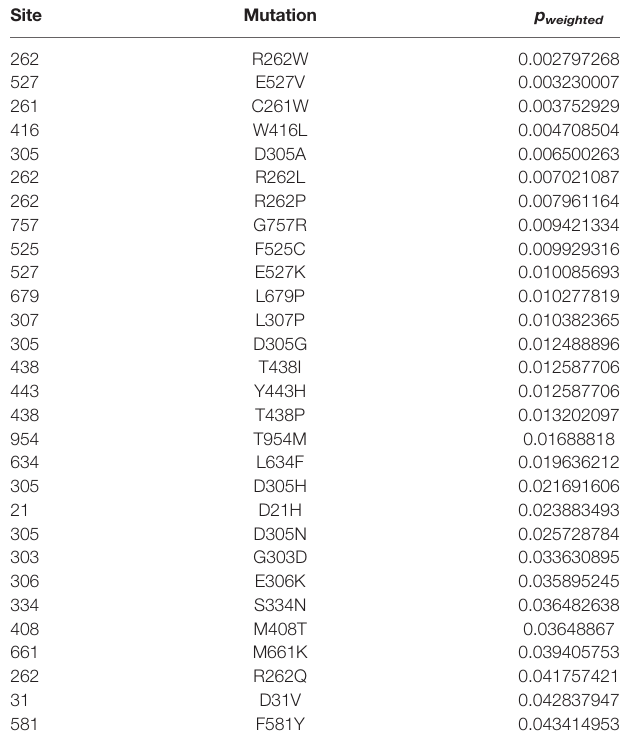
TABLE 2 | Ranked Combinatorial Scores for NLRP3 Mutants with p w <